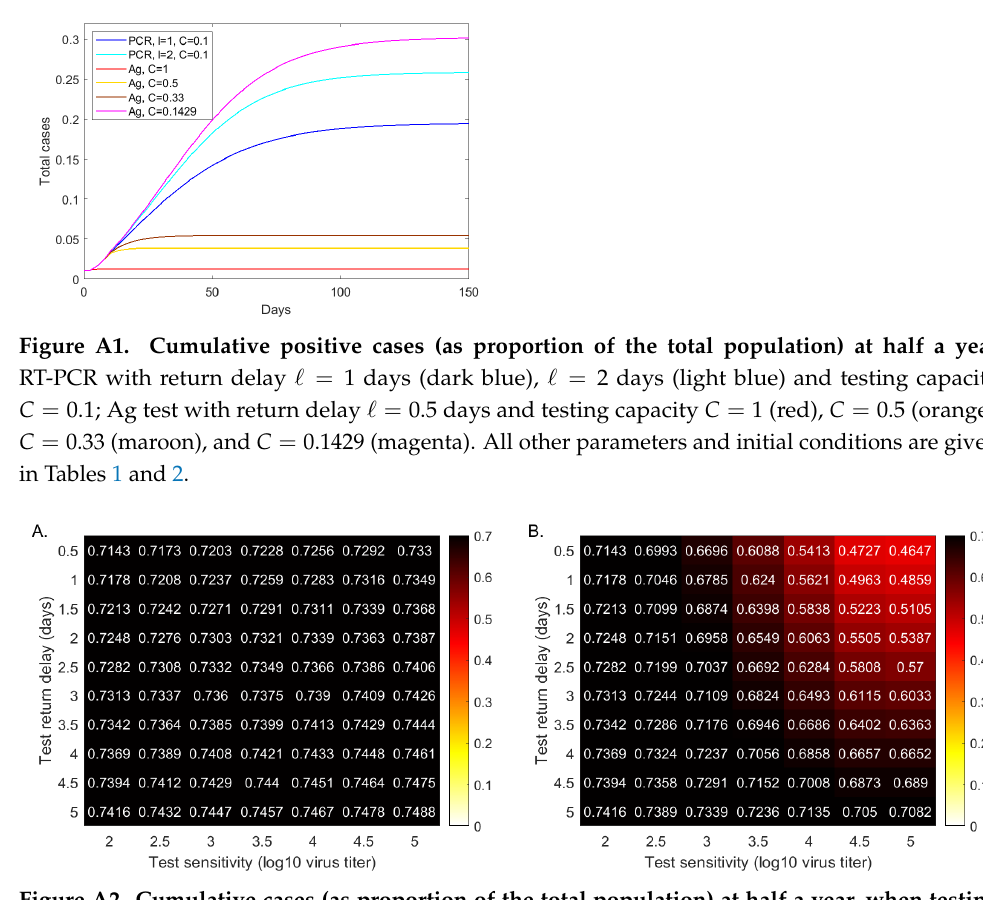
Figure A2. Cumulative cases (as proportion of the total population) at half a year, when testing 1% of the population daily. Heatmaps for the cumulative cases (as proportion of the total population) at half a year after the outbreak (% of the total population) as given by model Equation (5) versus test sensitivity and test return delay. Panel ( A ): fixed testing capacity per day, C = 0.01. Panel ( B ): fixed testing budget per day. All other parameters and initial conditions are given in Tables 1 and